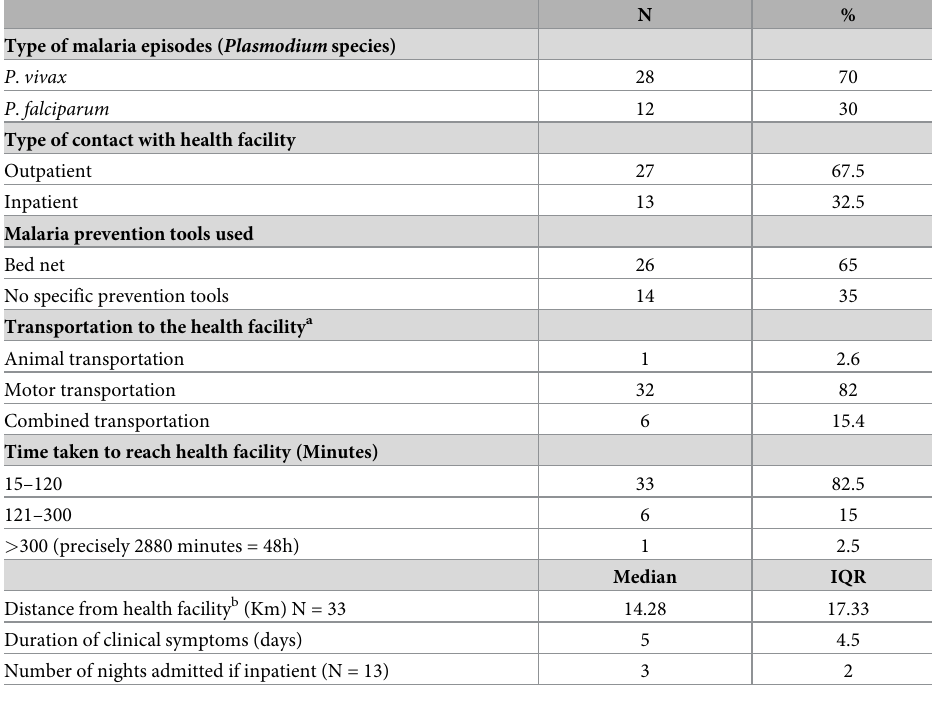
Table 2. Characteristics of malaria episodes (N =